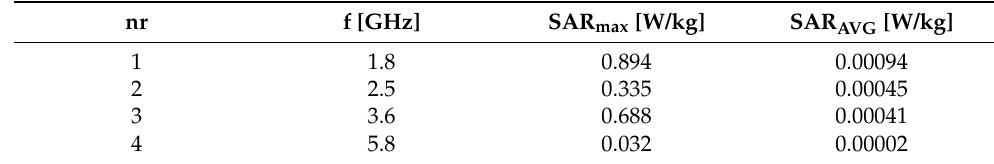
Table 8. SAR values averaged in 10 g of